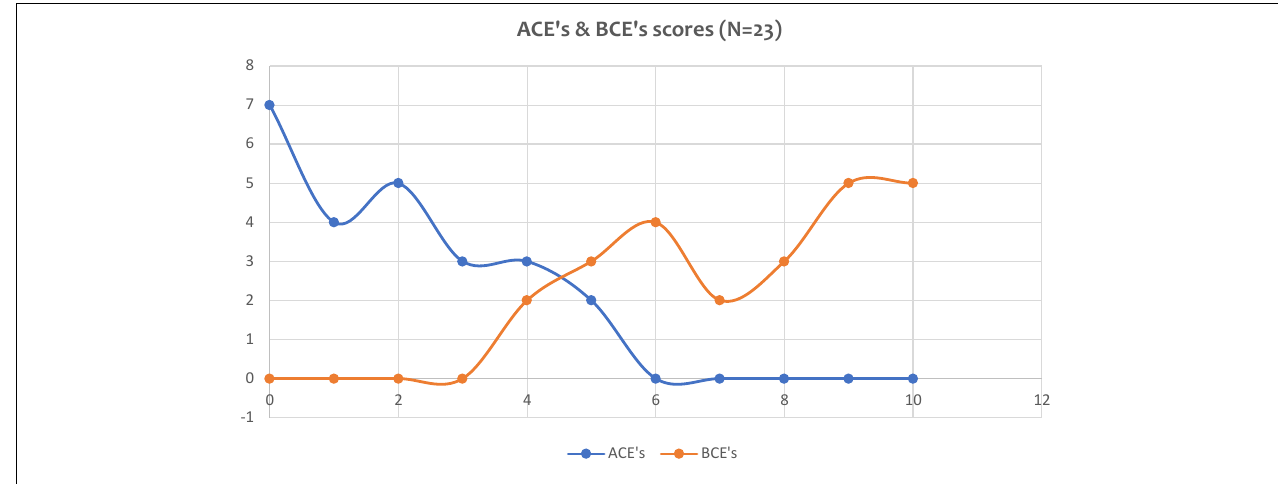
FIGURE 6 | Frequency of ACE and BCE scores of the research participants.